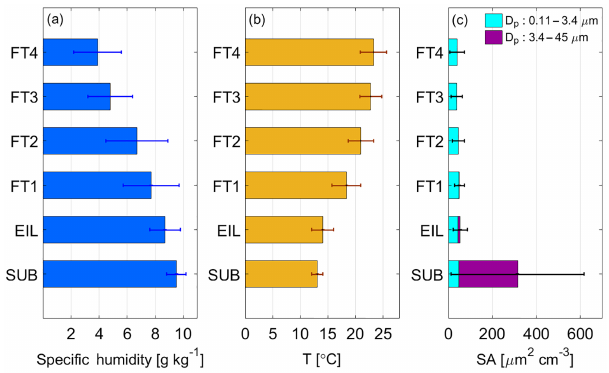
Figure 3. Particle concentrations in different diameter ranges (3–10, 10–110, and 110–3400nm) for SUB, EIL, and FT vertical layers. The FT is divided into four layers based on 100m increments above the EIL top. Whiskers represent 1 standard deviation.